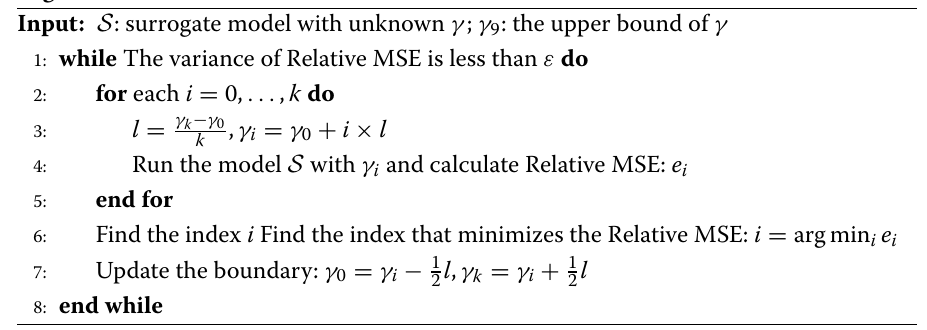
Algorithm 3 Parameter